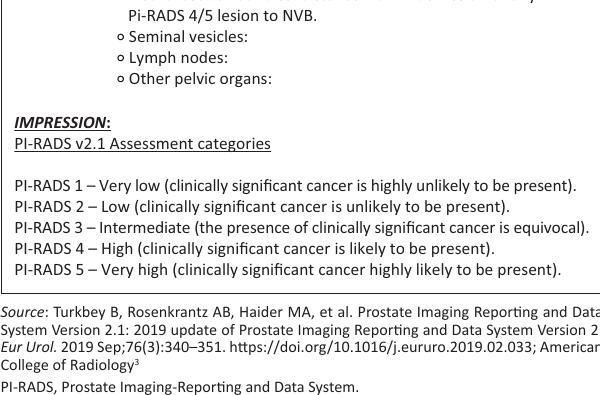
FIGURE 9: The anterior fibromuscular stroma shows marked homogeneously T2- hypointense signal (a). It is ADC hypointense (b) and diffusion-weighted imaging iso-intense